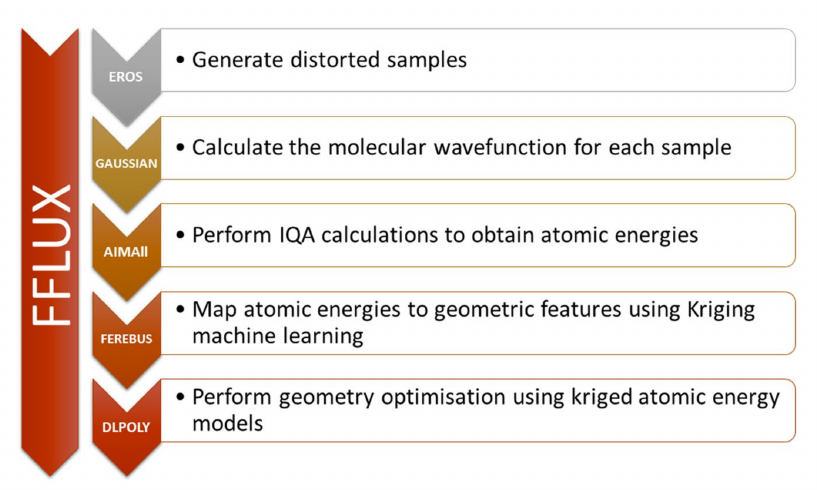
Figure 7. Flowchart representing the different stages in the training (first four steps) and execution (DL_POLY) of the, detailing the programs involved and summaries of their tasks. Figure taken from reference